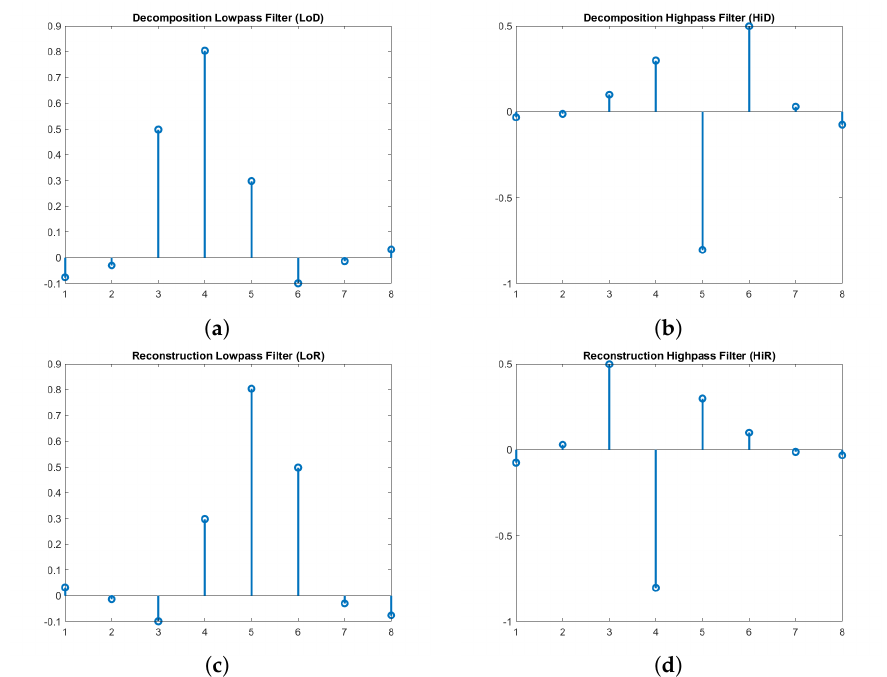
Figure 6. Four filters of the symlet4 wavelet: ( a ) Low-pass in Decomposition (LoD). ( b ) High-pass in Decomposition (HiD). ( c ) Low-pass in Reconstruction (LoR). ( d ) High-pass in Reconstruction